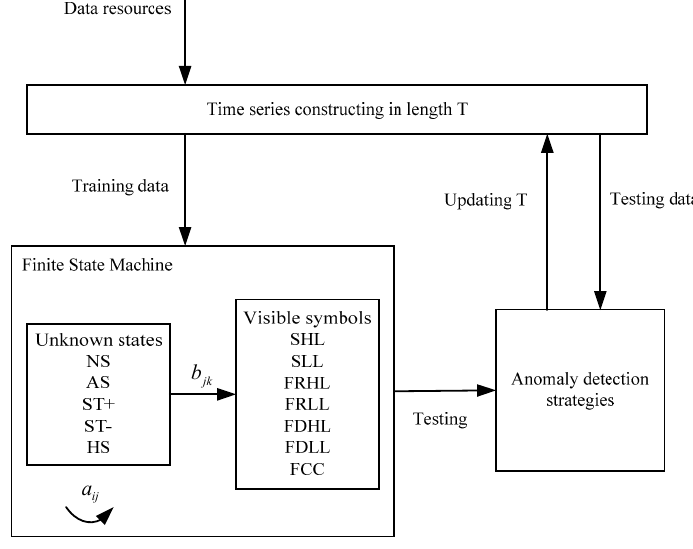
Figure 9. Schematic of FSM modeling procedures.